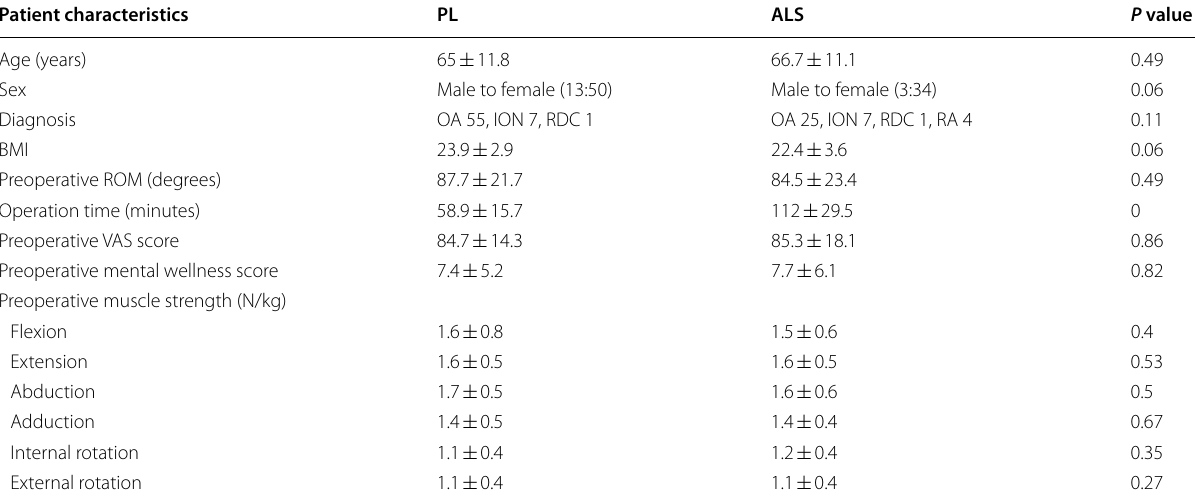
Table 3 Demographic data of patients in the PL and ALS groups